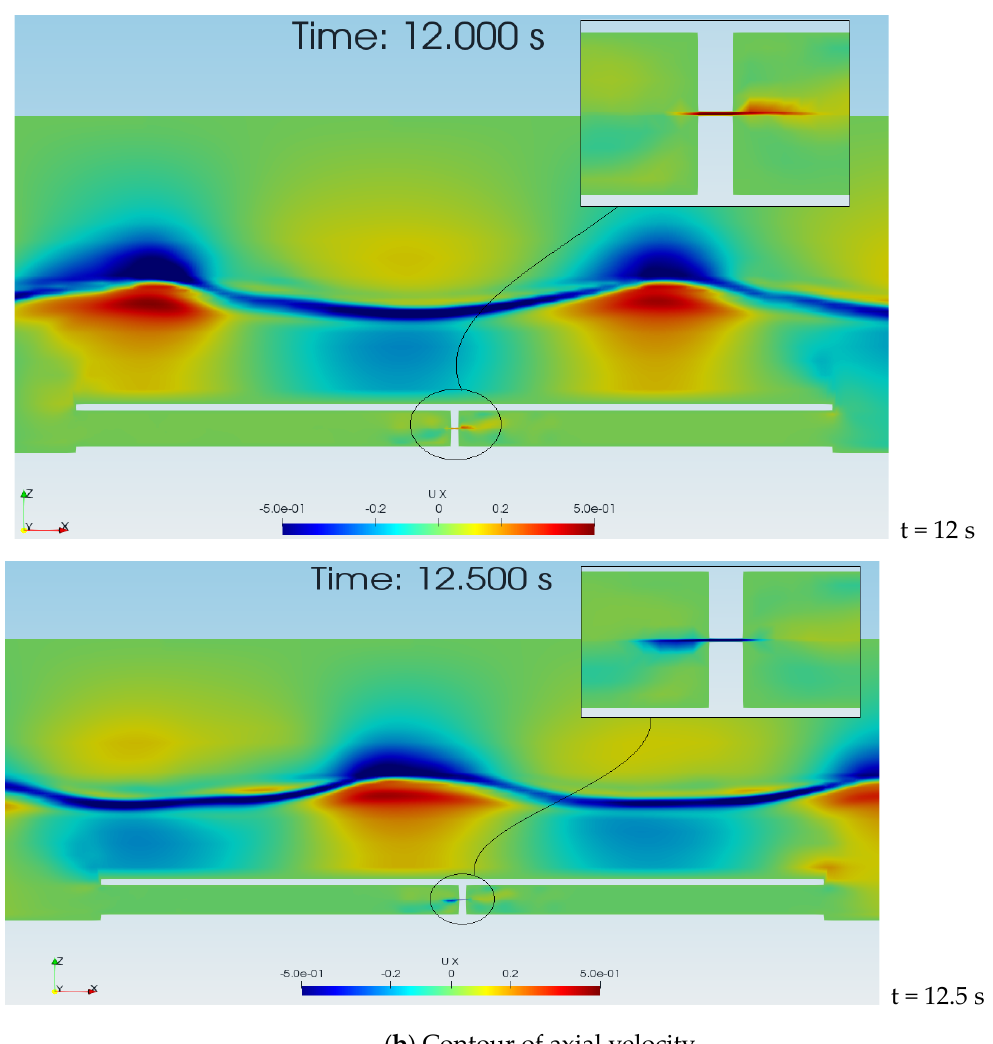
Figure 4. ( a ) Contour plots of volume fraction of water show the structure of the wave, ( b ) Contour plots of axial velocity showing reversing flow through the submerged pipe.